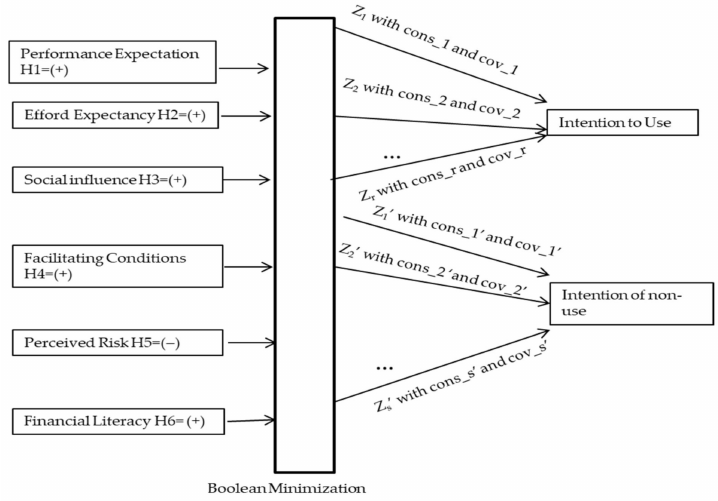
Figure 4. Hypothesis tested and analytical methodology with